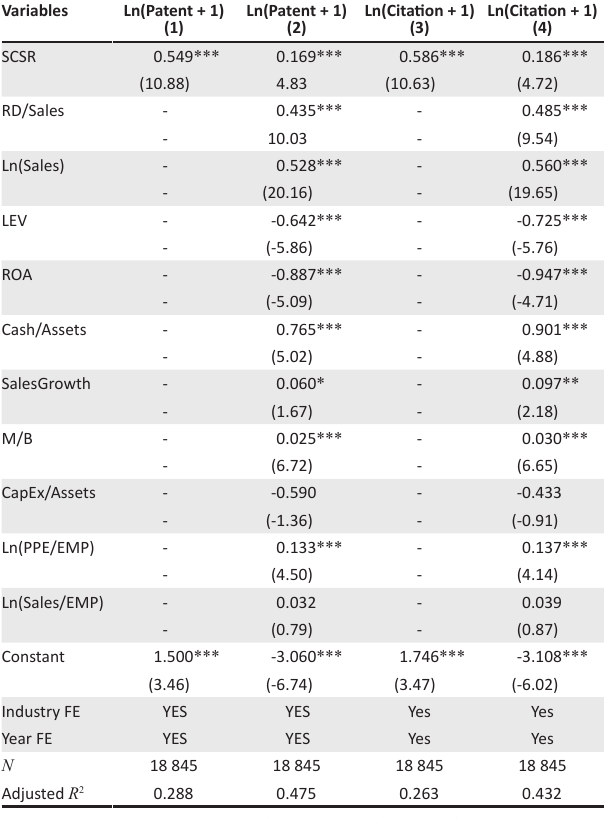
TABLE 3: Strategic corporate social responsibility and corporate innovation. Variables